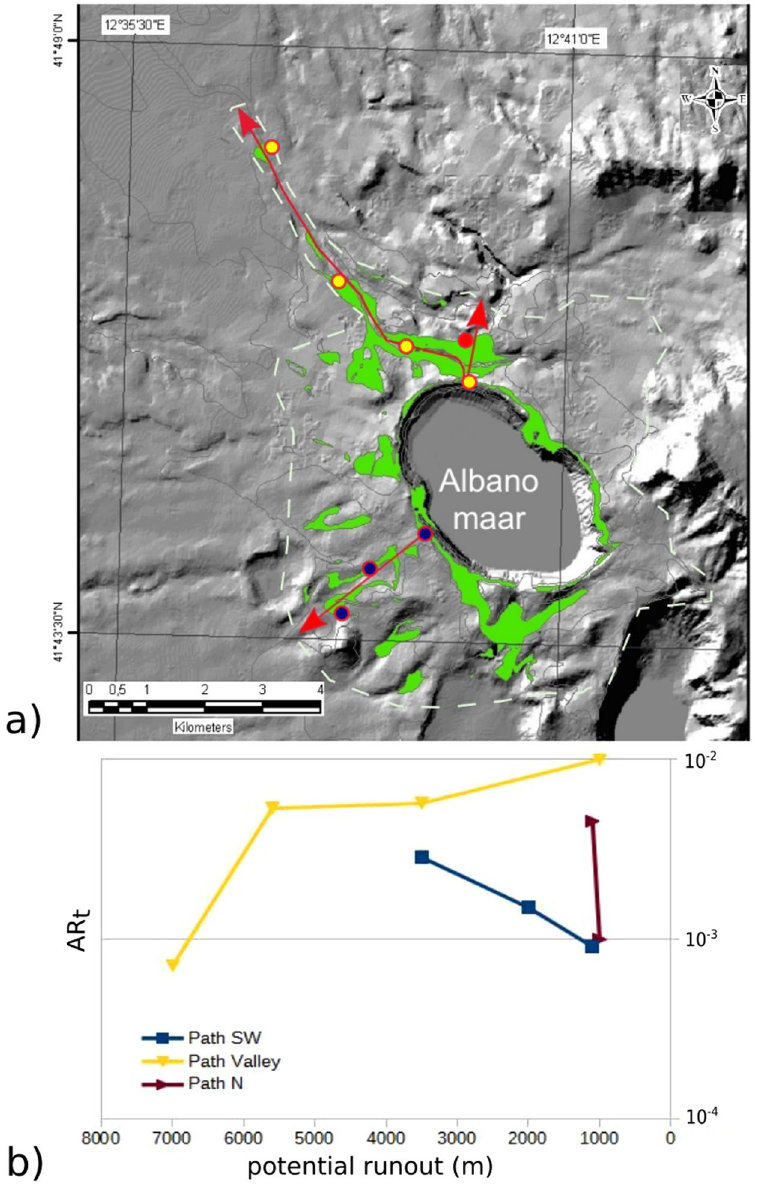
Figure 3. Topological aspect ratio (AR t ) of the Peperino Albano (Colli Albani, Italy; see Table S1 in Suppl. Material for characteristics; see Fig. 1 for location of Albano maar); ( a ) Areal extent of the phreatomagmatic ignimbrite (outcrops in green; hillshade image elaborated from Digital Terrain Model resolution 30 m available at www.pcn.minambiente.it/GN); dashed white line indicates the envelope of the maximum extent of the deposits; yellow, red and blue dots indicate sites with measured sections used for calculation of AR t along paths indicated by red arrows (see Table S2, Supplementary Material; data from 25, 27 ) – ( b ) Plot of potential runout versus topological aspect ratio AR t . Path SW and Path N both show a rapid decrease of AR t indicating inertial flow conditions and a rapid dissipation of the internal flow pressure that is by contrast maintained by channellization along the Path Valley, where AR t shows an increase with distance (see text for explanation). (drawing realized with Inkskape ver 0.91